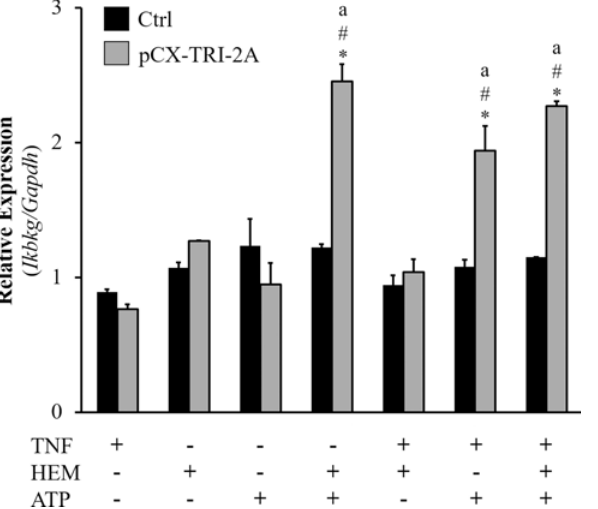
Fig 7. Changes in Ikgkb ( Nemo ) mRNA expression in control (Ctrl) and pCX-TRI-2A-transfected cells. Cells were incubated with 50 ng/ml TNF- α for 16h, alone or in combination with 20 μ M hemin and/or 200 μ M ATP. Murine Ikgkb mRNA was quantified by real-time PCR. The data (mean ± SD of three independent experiments), normalized for Gapdh gene, are expressed as fold change respect to the untreated cells. [ * ] indicates a significant difference between pCX-TRI-2A-transfected cells and Ctrl cells within the same treatment (t Student, p < 0.05); [#] indicates a significant difference as compared to untreated cells within the same cell type (ANOVA, p < 0.05) [a] indicates a significant difference as compared to TNF- α treatment alone within the same cell type (ANOVA, p <